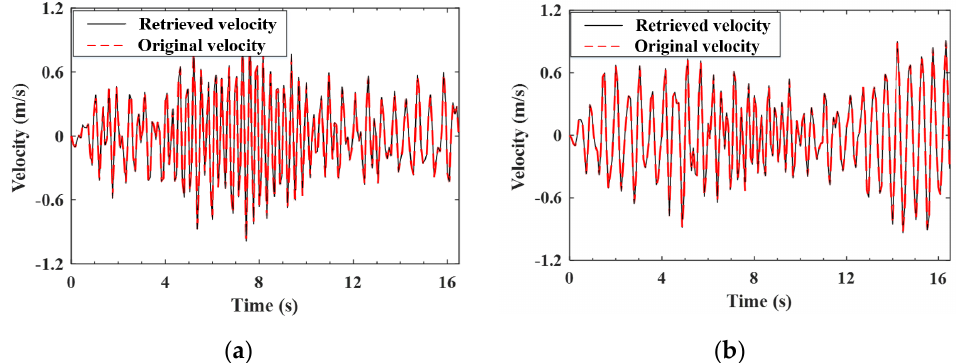
Figure 7. Retrieved and original velocity responses of the test vehicle (Class C roughness). ( a ) front axle; ( b ) rear axle.